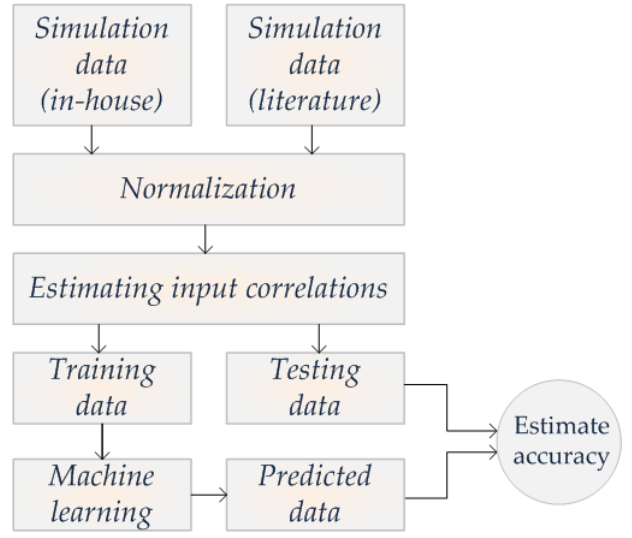
Figure 3. ML data flow.